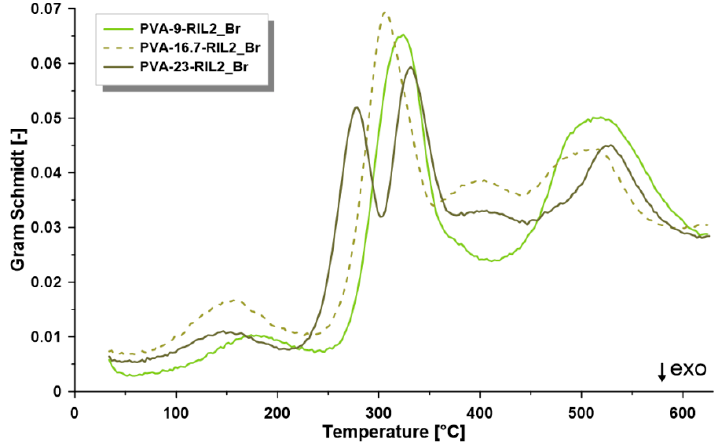
Figure 8. Gram–Schmidt diagram for PVA-9-RIL2_Br, PVA-16.7-RIL2_Br, and PVA-23-RIL2_Br membranes.